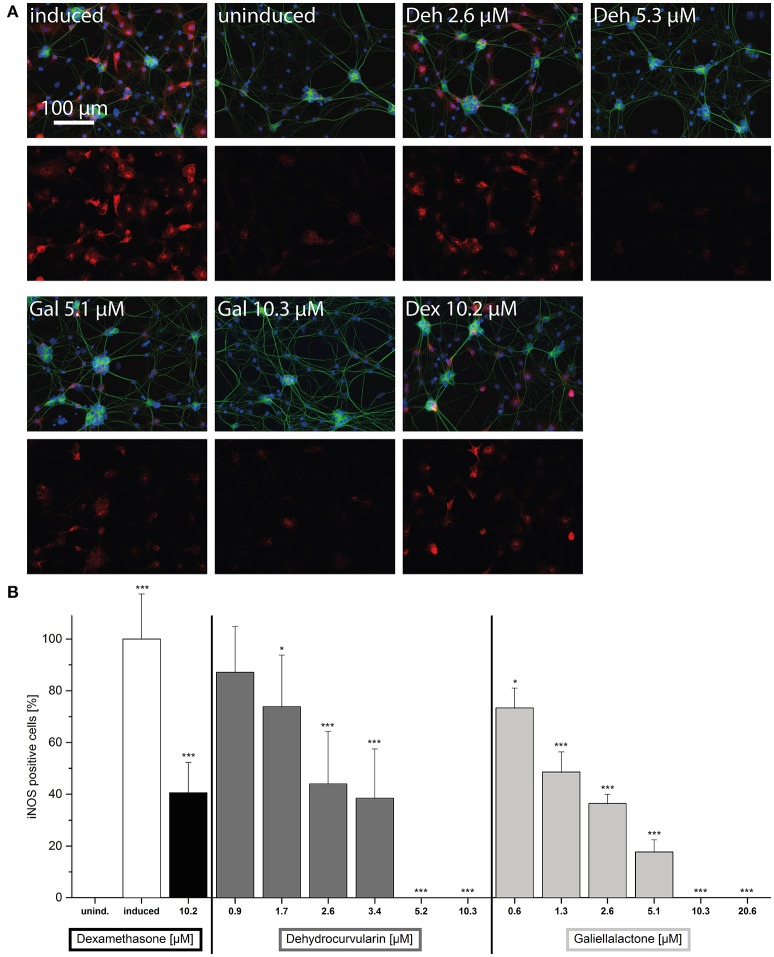
Effects of the anti-inflammatory compounds dehydrocurvularin, galiellalactone, and dexamethasone on iNOS expression in the postnatal ENS single cell culture. Cells were pretreated for 1 h with the indicated concentrations of test compounds prior to stimulation with CM for 24 h. (A) Neurons (green, βIII-Tubulin), iNOS positive cells (red, iNOS) and nuclei (blue, DAPI). The upper row shows a merge of all three fluorescence channels, the lower row the iNOS expression. (induced): cytokine induced culture, (uninduced): uninduced control culture, (Deh 2.6 μM): dehydrocurvularin 2.6 μM, (Deh 5.3 μM): dehydrocurvularin 5.3 μM, (Gal 5.1 μM): galiellalactone 5.1 μM, (Gal 10.3 μM): galiellalactone 10.3 μM, (Dex 10.2 μM): dexamethasone 10.2 μM. 5000 cells / coverslip. (B) Results are relative to positive control. The data are presented in comparison to cytokine induced control cells (±SD). *p < 0.05; **p < 0.01; ***p < 0.001, treated cells vs. cytokine induced cells, respectively cytokine induced cells vs. uninduced cells. At least 4 independent experiments were performed.